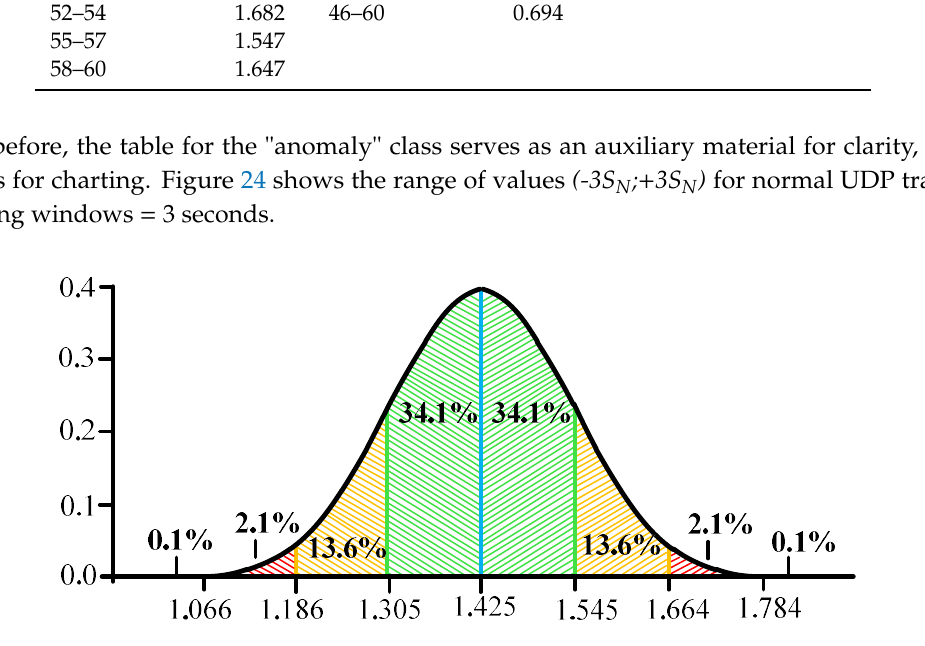
Figure 24. Range of values (-3S N ;+3S N ) for normal UDP traffic for monitoring windows = 3 seconds.